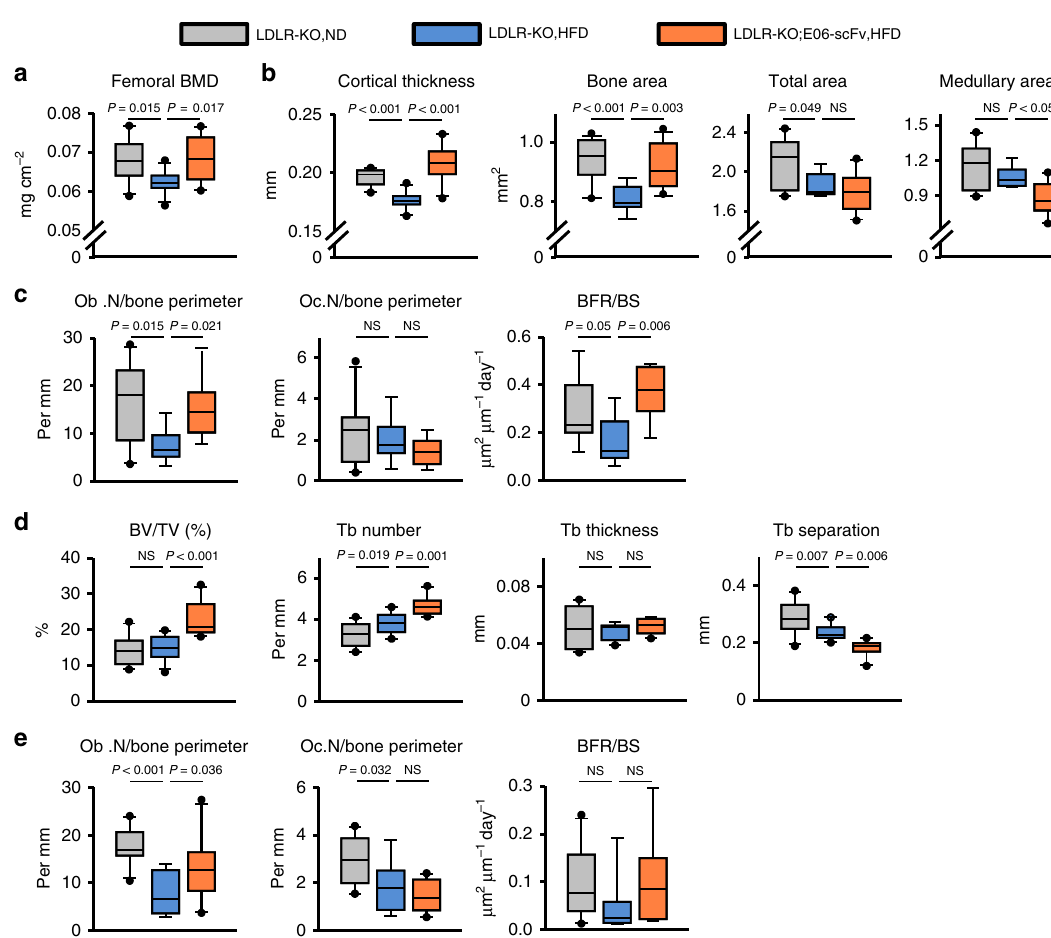
Fig. 3 E06-scFv attenuates the HFD-induced loss of cortical bone and increases cancellous bone. a Femoral BMD in 6.5-month-old male mice (LDLR-KO, ND, n = 10; LDLR-KO, HFD, n = 11; LDLR-KO;E06-scFv, HFD, n = 10). b Femoral cortical bone architecture in 7.5-month-old male mice (cortical thickness: LDLR-KO, ND, n = 10; LDLR-KO, HFD, n = 11; LDLR-KO;E06-scFv, HFD, n = 10; area measurements: LDLR-KO, ND, n = 10; LDLR-KO, HFD, n = 8; LDLR-KO; E06-scFv, HFD, n = 10). c Histomorphometry of the endocortical femoral surface (osteoblast and osteoclast numbers: LDLR-KO, ND, n = 10; LDLR-KO, HFD, n = 8; LDLR-KO;E06-scFv, HFD, n = 9; BFR/BS: LDLR-KO, ND, n = 9; LDLR-KO, HFD, n = 9; LDLR-KO;E06-scFv, HFD, n = 7). d Femoral cancellous bone architecture at 7.5 months (LDLR-KO, ND, n = 10; LDLR-KO, HFD, n = 11; LDLR-KO;E06-scFv, HFD, n = 10). e Histomorphometry of the cancellous femoral surface (osteoblast and osteoclast numbers: LDLR-KO, ND, n = 10; LDLR-KO, HFD, n = 8; LDLR-KO;E06-scFv, HFD, n = 10; BFR/BS: LDLR-KO, ND, n = 10; LDLR-KO, HFD, n = 9; LDLR-KO;E06-scFv, HFD, n = 9). Data analyzed by ANOVA except for medullary area which were analyzed by ANOVA on Ranks. Data shown represent the mean (±SD). Ob.N osteoblast number, Oc.N osteoclast number, BFR bone formation rate, BS bone surface, NS